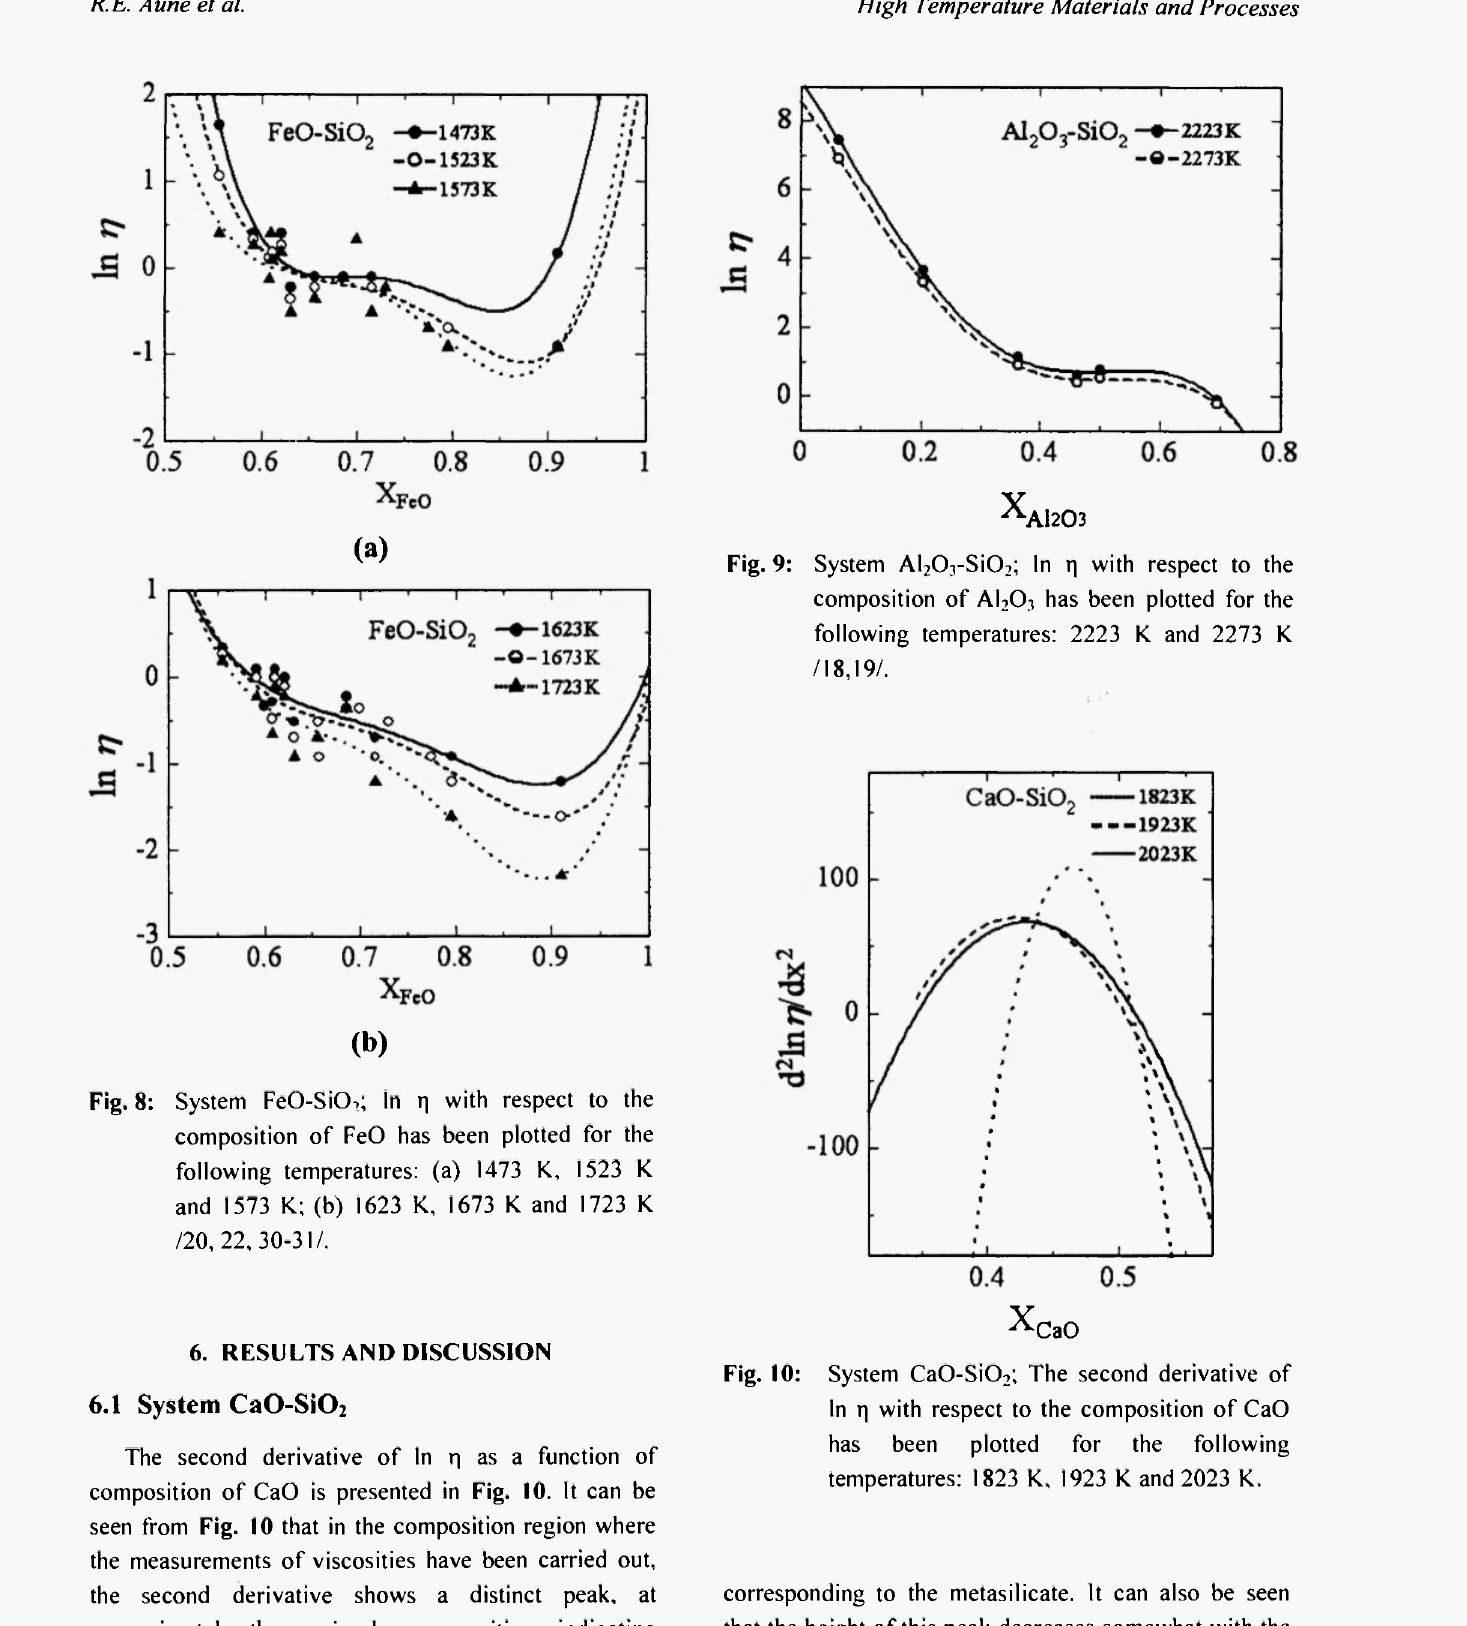
Fig. 10: System Ca0-Si0 2 ; The second derivative of In η with respect to the composition of CaO has been plotted for the following temperatures: 1823 K, 1923 Κ and 2023